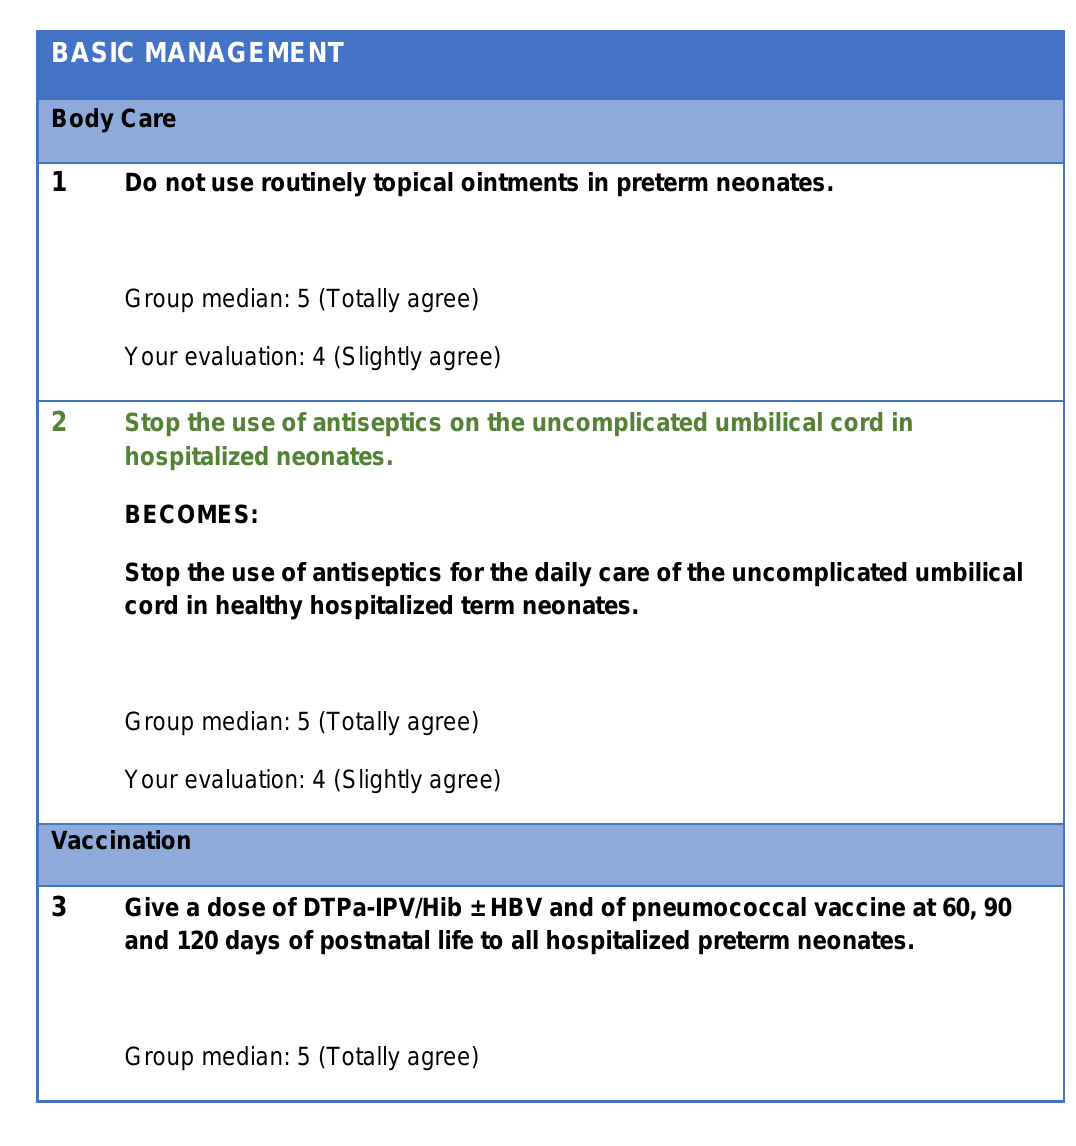
Excerpt of a table provided to an expert during the 2 nd round of Delphi with the level of agreement he noted during 1 st round and the median agreement level of the expert